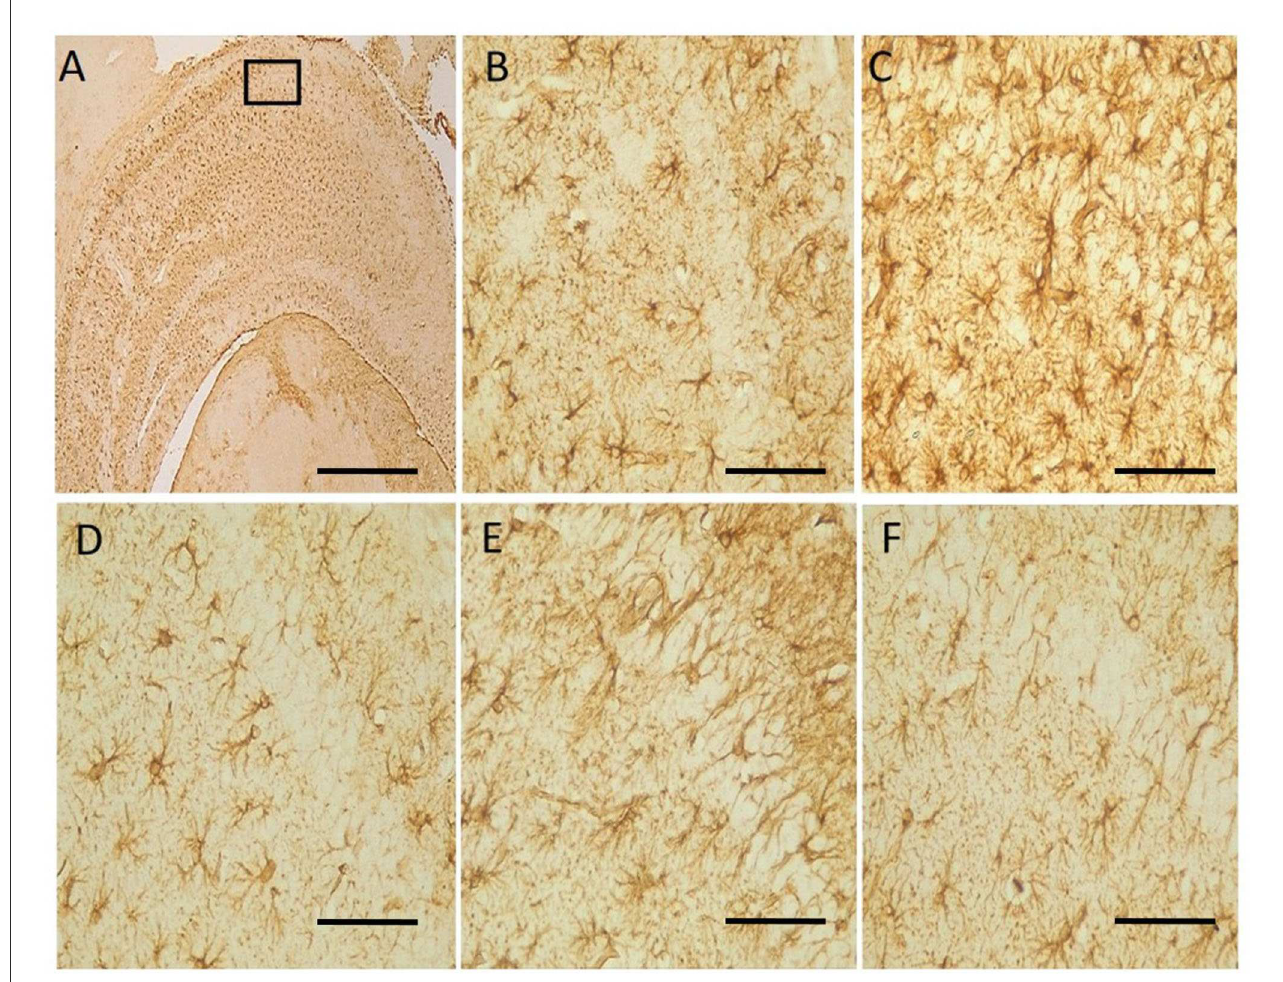
FIGURE7 Photomicrograph of anti-GFAP immuno-stained CA1 region of the hippocampus of control and experimental mice. Untreated hydrocephalus group (C) revealed astrocytic activation identified by thickened cell body with extended processes and dense population relative to control while vanadium treatment showed an attempt at mitigating the effect of hydrocephalus relative to the untreated group (B–F) . (A) Control [insert box: area magnified in (B–F) ], (B) control, (C) untreated hydrocephalus, (D) hydrocephalus + low dose vanadium, (E) hydrocephalus + intermediate dose vanadium, and (F) hydrocephalus + high dose vanadium; [Scale bar, (A) 50 µ m; (B–F) 4 µ